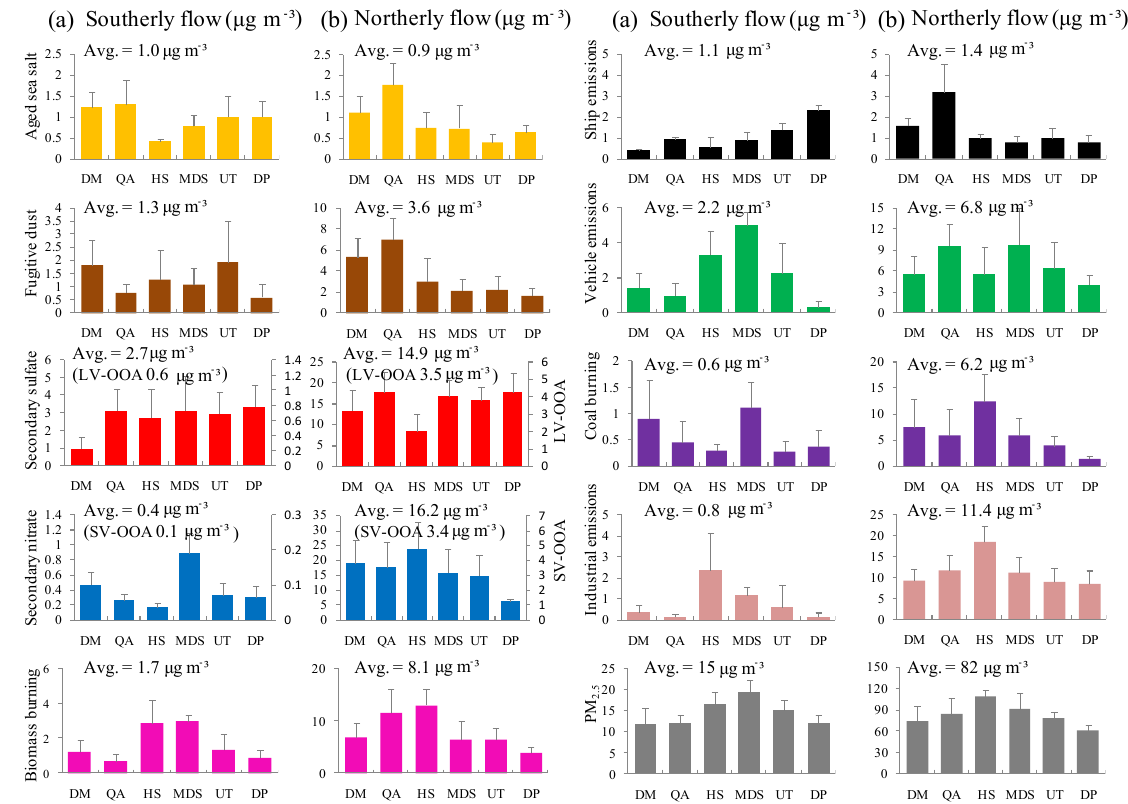
Figure 8. The average contributions of PM 2 . 5 sources at six sites in the PRD: (a) those in southerly flow and (b) those in northerly